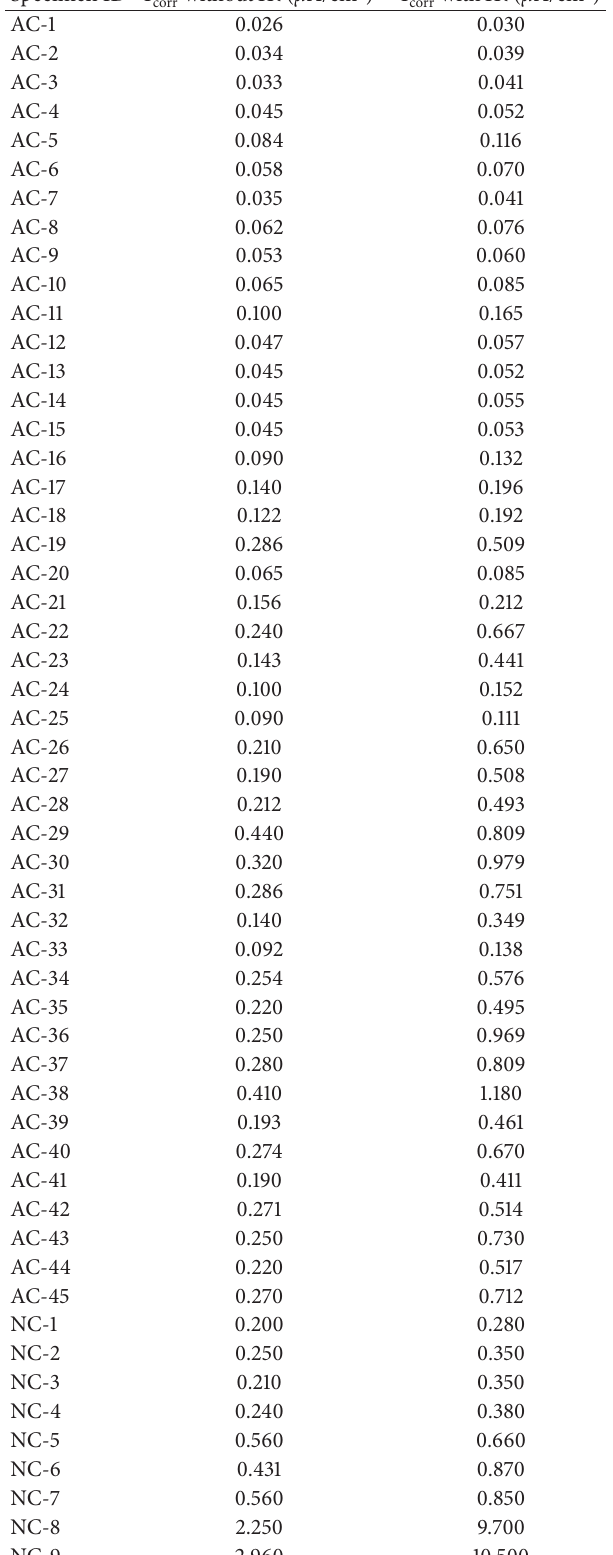
Table 3: 𝐼 (with and without 𝐼𝑅 compensation) measured using corr developed setup.